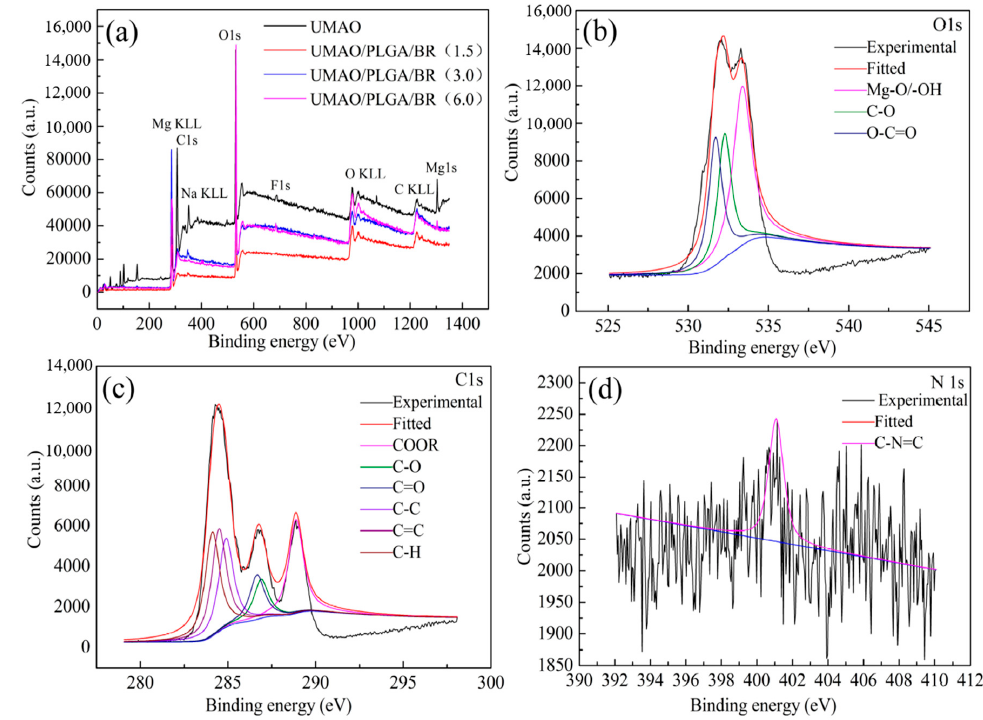
Figure 6. X-ray photoelectron spectroscopy (XPS) spectra of coatings with various BR additions: ( a ) survey spectrum; ( b ) O 1 s spectra; ( c ) C 1 s spectra; ( d ) N 1 s spectra. Table 4. Corrosion current densities and corrosion potentials for different coatings in SBF at 37 ± 1 °C.